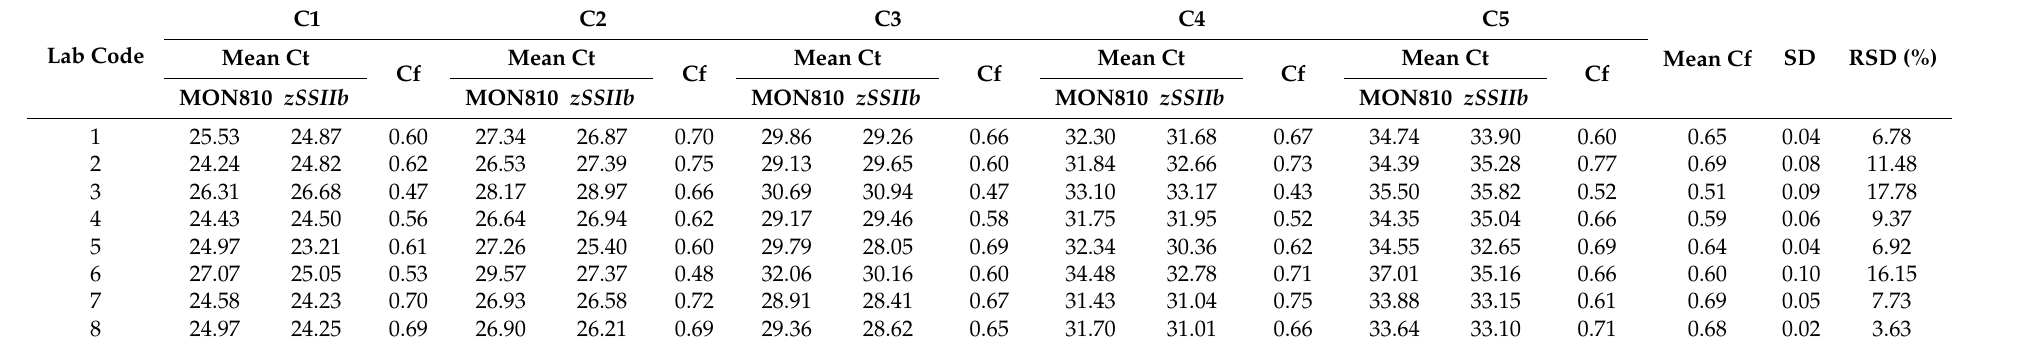
Table 2. Conversion factor (Cf) values from eight laboratories in the inter-laboratory study.